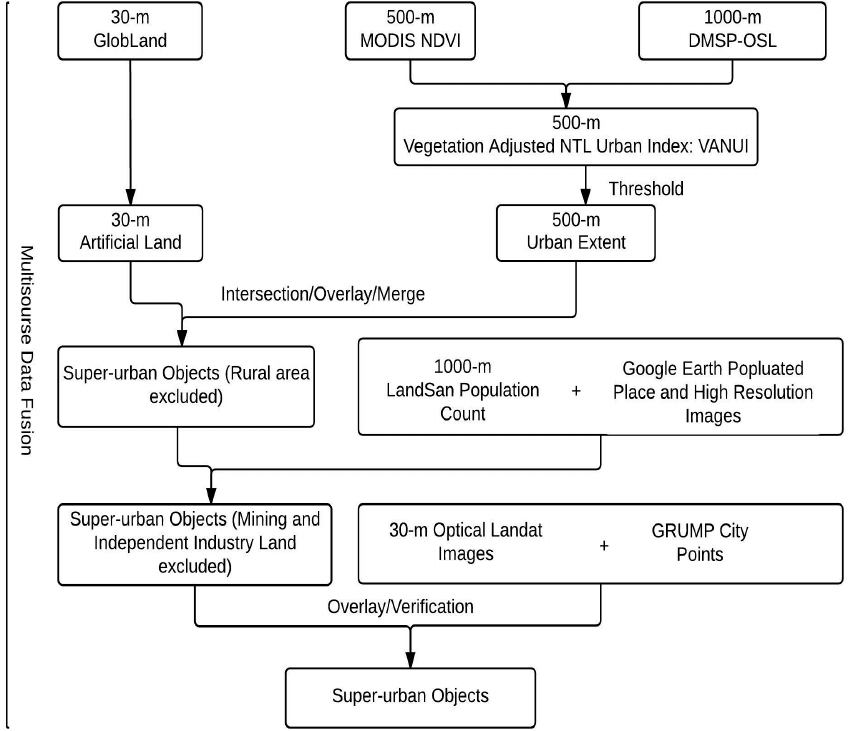
Figure 3. Flowchart creating super urban objects with data fusion from multiple sources. The super urban objects confine image areas that need further classification. NDVI is normalized difference vegetation index. NTL is nighttime light.